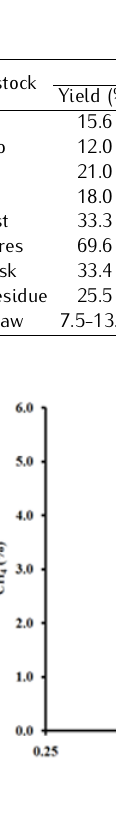
Figure 3. The variation in the CO evolution with the carrier gas flow rate and the type of feedstock.